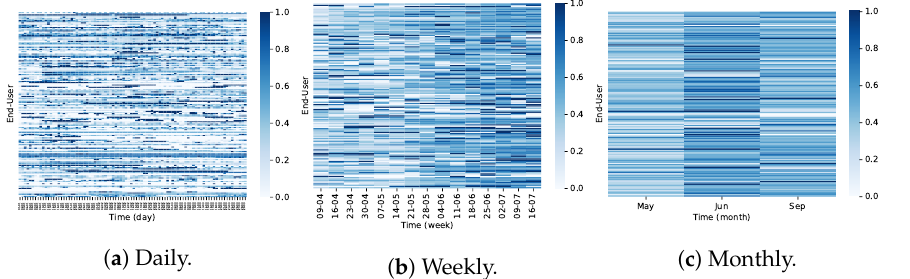
Figure 19. Illustration of the selected coclusters (Cocluster 0, Cocluster 2, and Cocluster 1) found on the daily, weekly, and monthly datasets at InfraQuinta, 2017.